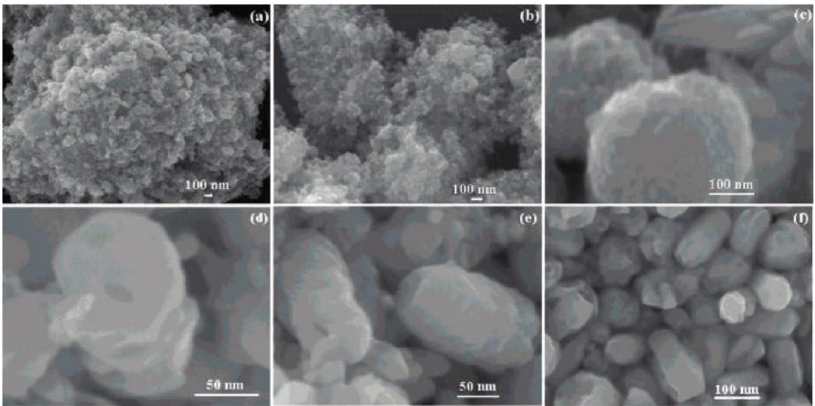
Figure 54. SEM images of ( a ) Ag:ZnO molar ratio of 0, ( b ) Ag:ZnO molar ratio of 0.02, ( c ) Ag:ZnO molar ratio of 0.05, ( d , e ) Ag:ZnO molar ratio of 0.13, ( f ) Ag:ZnO molar ratio of 0.22. Reprinted (adapted) with permission from [805]. Copyright (2008) American Chemical Society. All rights reserved. In order to re-use permission must be obtained from the rightsholder.